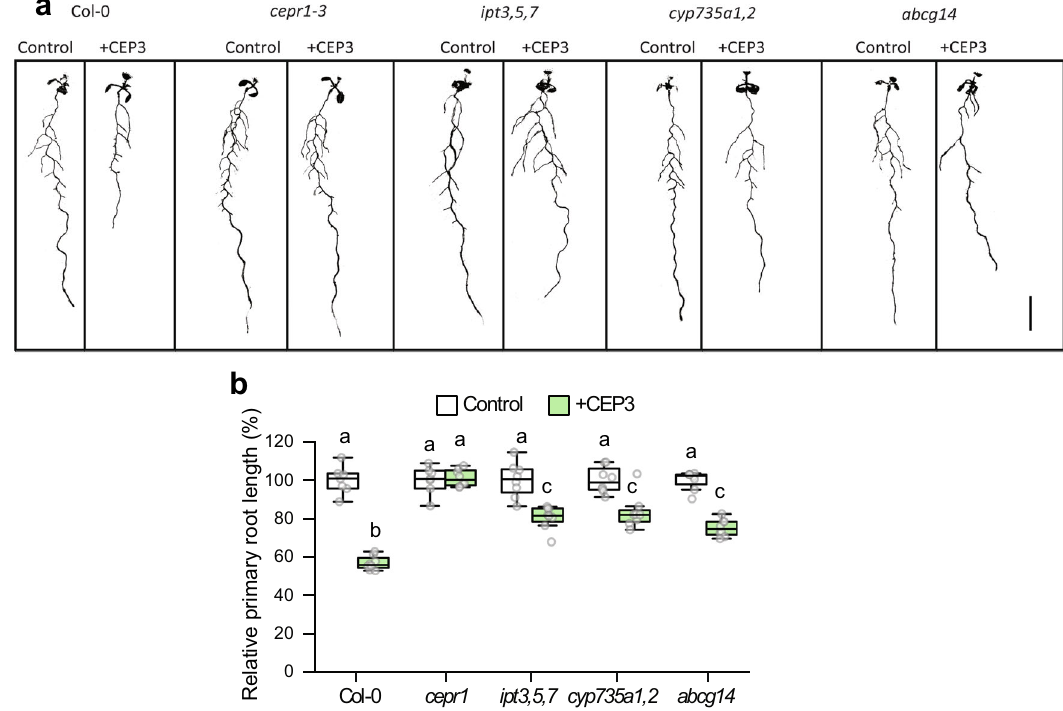
Fig. 1 | CEP sensitivity depends on cytokinin biosynthesis and transport. a Representative images and ( b ) relative primary root length for cytokinin bio- synthesis or transport mutants grown on medium with or without CEP3 peptide (10 − 6 M)for10daysincomparisontoCol-0and cepr1-3 ( n =7 – 8plants).Rootlength expressed as a percentage of seedlings grown on medium without CEP3 (control) for each respective genotype. Letters show signi fi cant differences (ANOVA